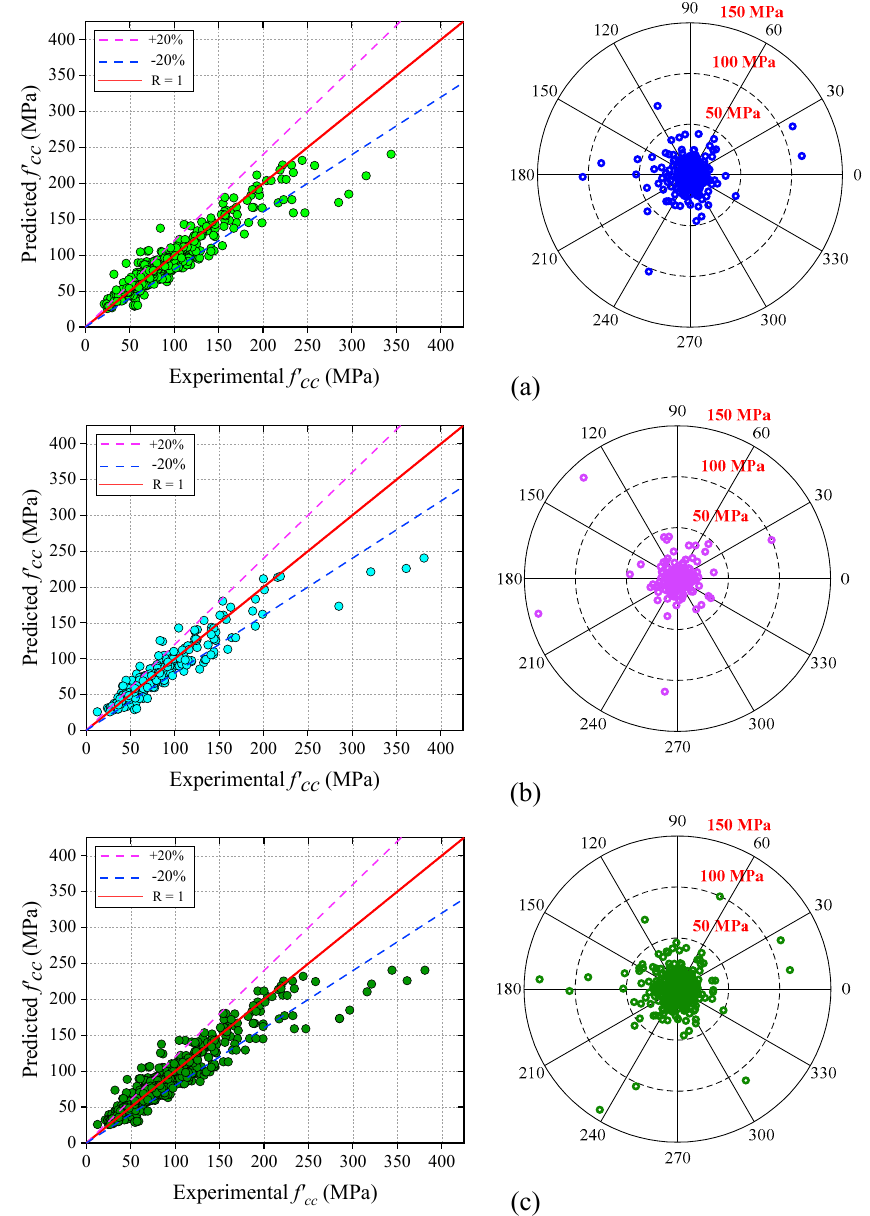
Figure 10. Scatter and absolute error plot of SVM model; ( a ) training, ( b ) testing, and ( c ) whole datasets.